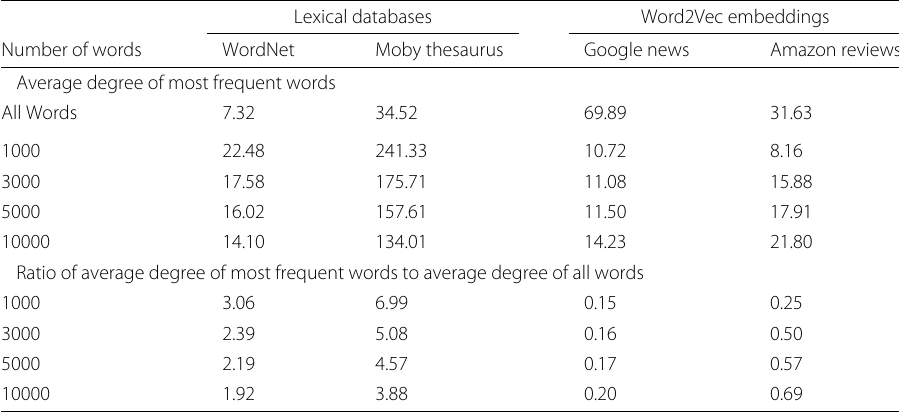
Table 6 Average degree of all nodes vs. average degree of words appearing in the lists of 1000, 3000, 5000 and 10000 most frequent words (from Moby Thesaurus ll and Beautiful Data, Natural Language Corpus data book (Norvig 2009)) in WordNet synonyms network, Moby Thesaurus and Word2Vec embedding of Google News and Amazon Reviews containing WordNet words (cosine similarity threshold =